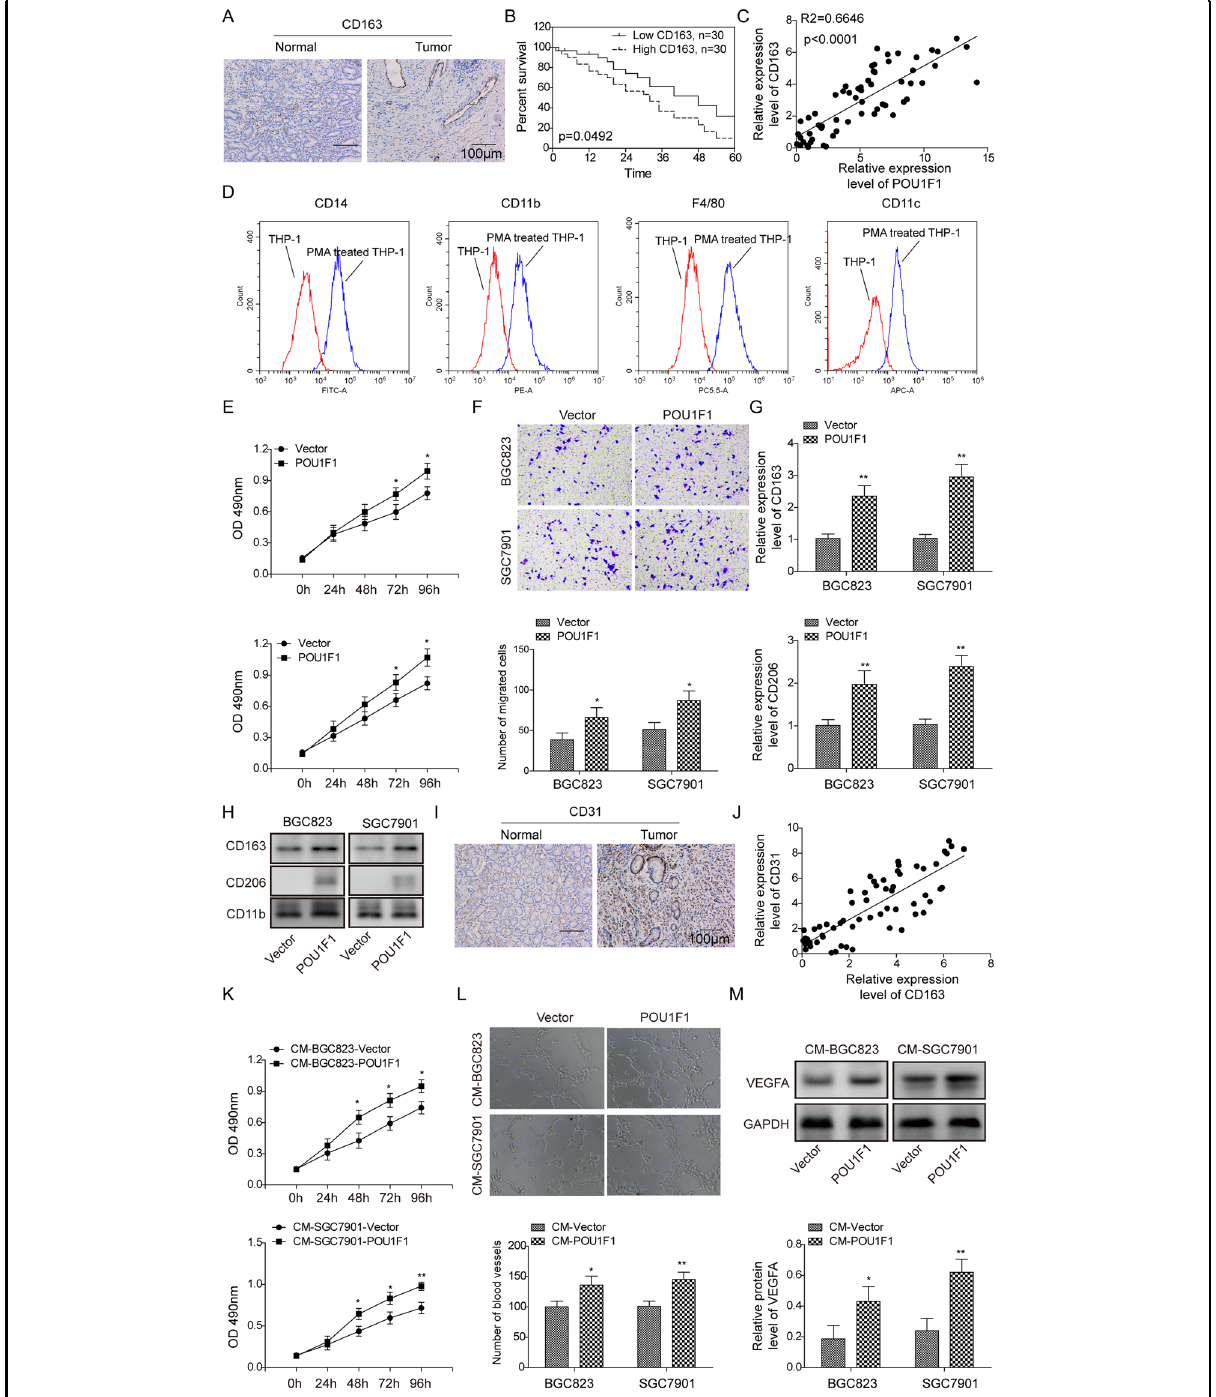
Fig. 5 POU1F1 promotes GC progression via regulating macrophage proliferation, migration, polarization, and angiogenesis. A The immunoreactivity of CD163 was assessed by IHC analysis. B Kaplan – Meier curves for overall survival of GC patients. C The correlation between CD163 and POU1F1 in GC was determined by Pearson correlation analysis. D Cell surface CD14, CD11b, F4/80, and CD11c expression were analyzed by fl ow cytometry. E Cell viability of macrophages was monitored by CCK-8 assay. F Cell migration of macrophages was determined by transwell migration assay. The mRNA ( G ) and protein ( H ) levels of CD163 and CD206 were detected by qRT-PCR and western blot, respectively. CD11b served as an internal control. ( I ) The immunoreactivity of CD31 was assessed by IHC analysis. J The correlations between CD31 and CD163 in GC were determined by Pearson correlation analysis. K Cell viability of HUVECs was monitored by CCK-8 assay. L In vitro angiogenesis was monitored by tube formation assay. M The protein level of VEGF was determined by western blot. GAPDH served as a loading control. Data were representative images or were expressed as the mean ± SD of n = 3 experiments. * P < 0.05, ** P < 0.01. Of fi cial journal of the Cell Death Differentiation